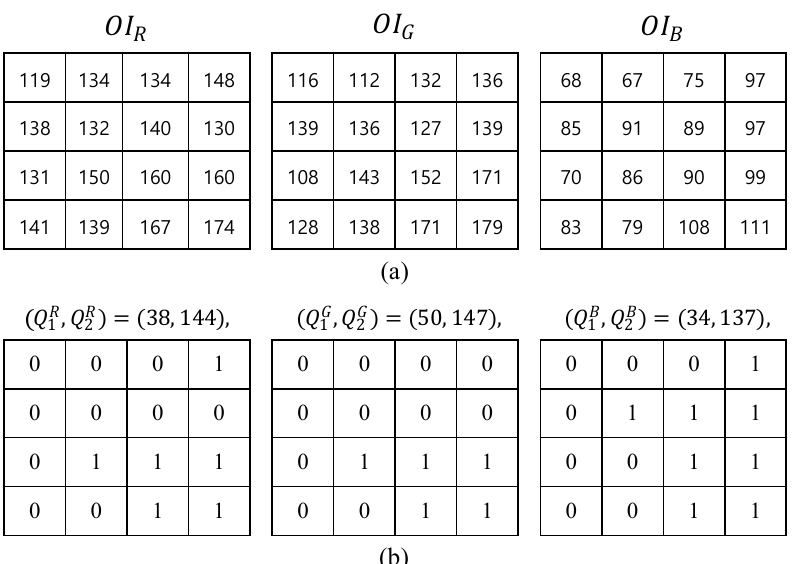
Figure 4. An example of the procedure of a block of traditional color AMBTC; ( a ) RGB blocks sized 4 × 4 of original image OI , ( b ) the three bitmaps of color AMBTC CT T . Traditional color AMBTC is compressed into two quantization levels and one bitmap